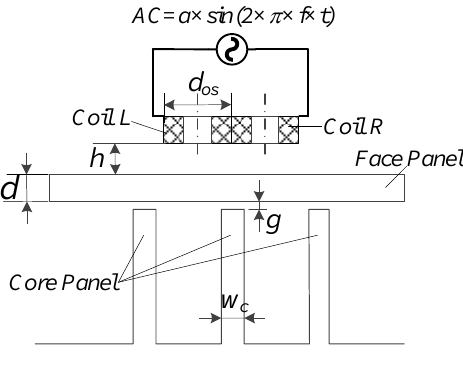
Figure 4. Primary influence factors of the eddy current sensor.